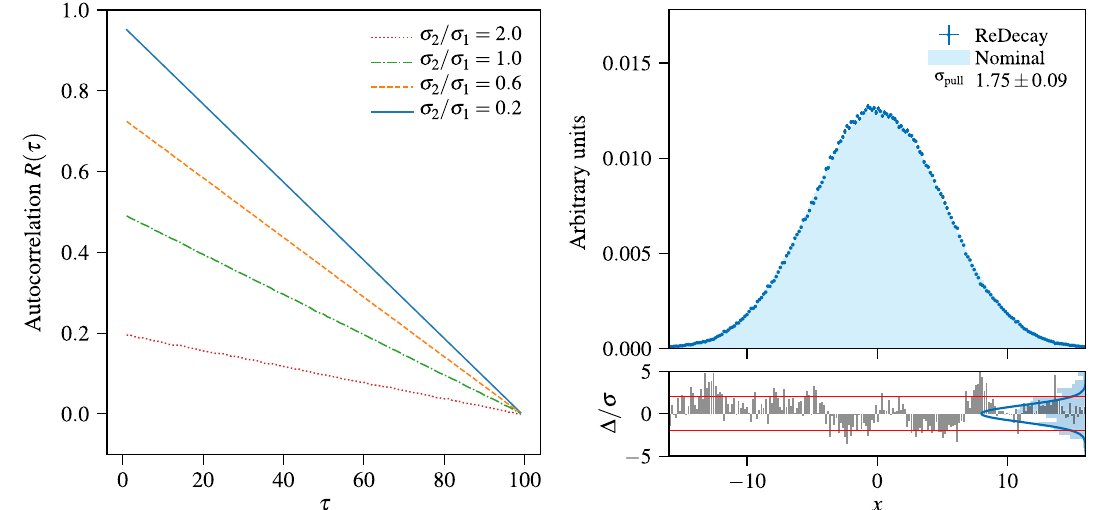
Fig. 1 Illustrationofthecorrelationsbetweeneventsproducedwiththe ReDecay method, using N ReDecay = 100: (left) autocorrelation func- tion R (τ) for different values of the ratios of widths of the probability density functions, σ 2 /σ 1 and (right) comparison of normalised distribu- tions of a variable x generated with the ReDecay method and a standard generation method (nominal) for σ 1 = 5 and σ 2 = 1. The bottom part of the right plot shows the pull distribution of the difference (cid:6) in each